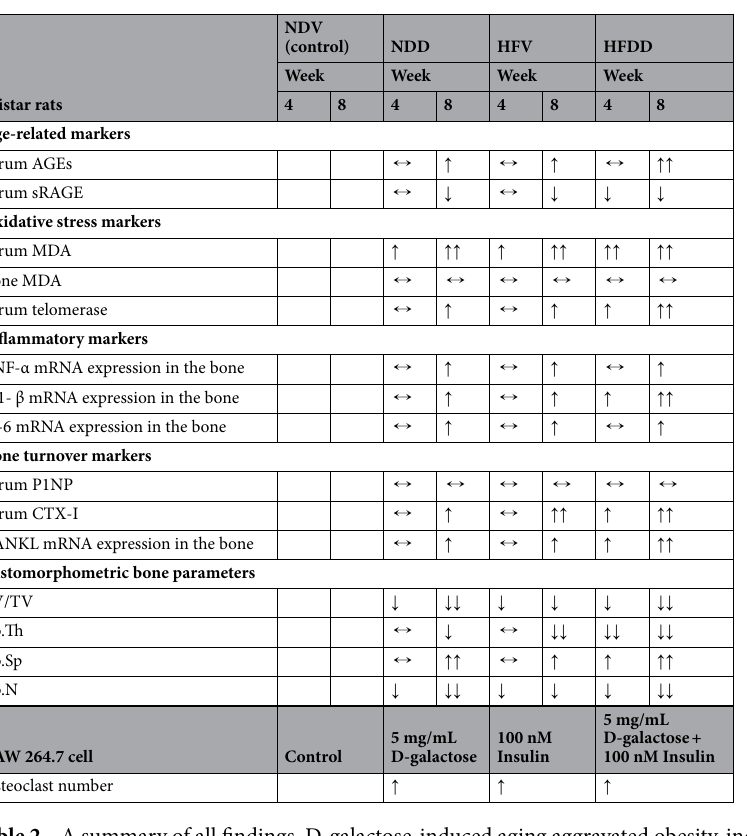
Table 2. A summary of all findings. D-galactose-induced aging aggravated obesity-induced systemic oxidative stress, bone inflammation, and bone dyshomeostasis in a time-dependent manner. Consistent with the in vivo study findings, the in vitro study confirmed underlying mechanisms associated with severe accelerated bone loss as a consequence of D-galactose- and hyperinsulinism-stimulated osteoclastogenesis. AGEs, Advanced glycation end products; BV/TV, Bone volume per tissue volume; CTX-I, C-terminal telopeptide of type I collagen; HFD, High-fat diet; HFDD, High-fat diet with D-galactose; HFV, High-fat diet with vehicle; MDA, Malondialdehyde; NDD, Normal diet with D-galactose ; NDV, Normal diet with vehicle; P1NP, Procollagen type I N-terminal propeptide; RANKL, Receptor activator of nuclear factor κB ligand; sRAGE, Soluble receptor for advanced glycation end products; Tb.N, Trabecular number; Tb.Sp, Trabecular separation; Tb.Th, Trabecular thickness; TRAP, Tartrate-resistant acid phosphatase; ↑ , Higher than NDVS group; ↑↑ , Much higher than NDVS group; ↓ , Lower than NDVS group; ↓↓ , Much lower than NDVS group; ↔ , No statistically significant difference when compared with NDV group at the same